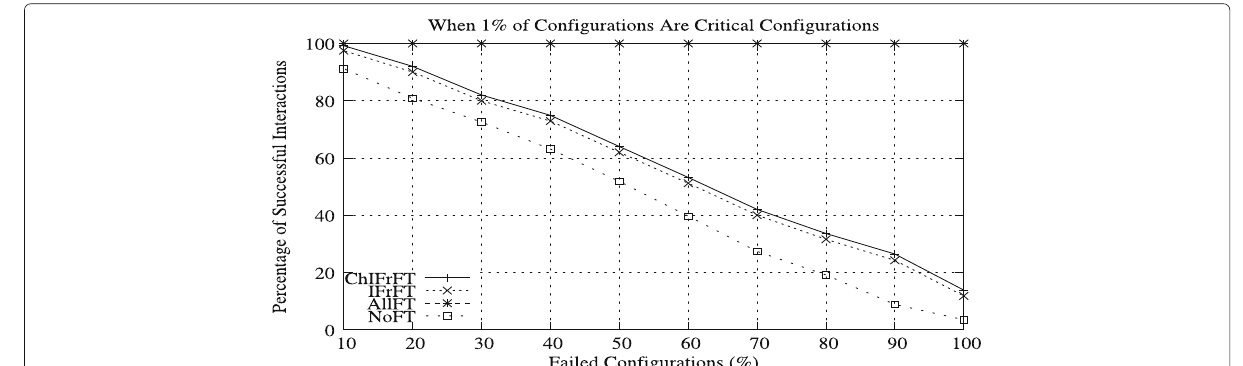
Fig. 8 Critical configurations are 1% of all